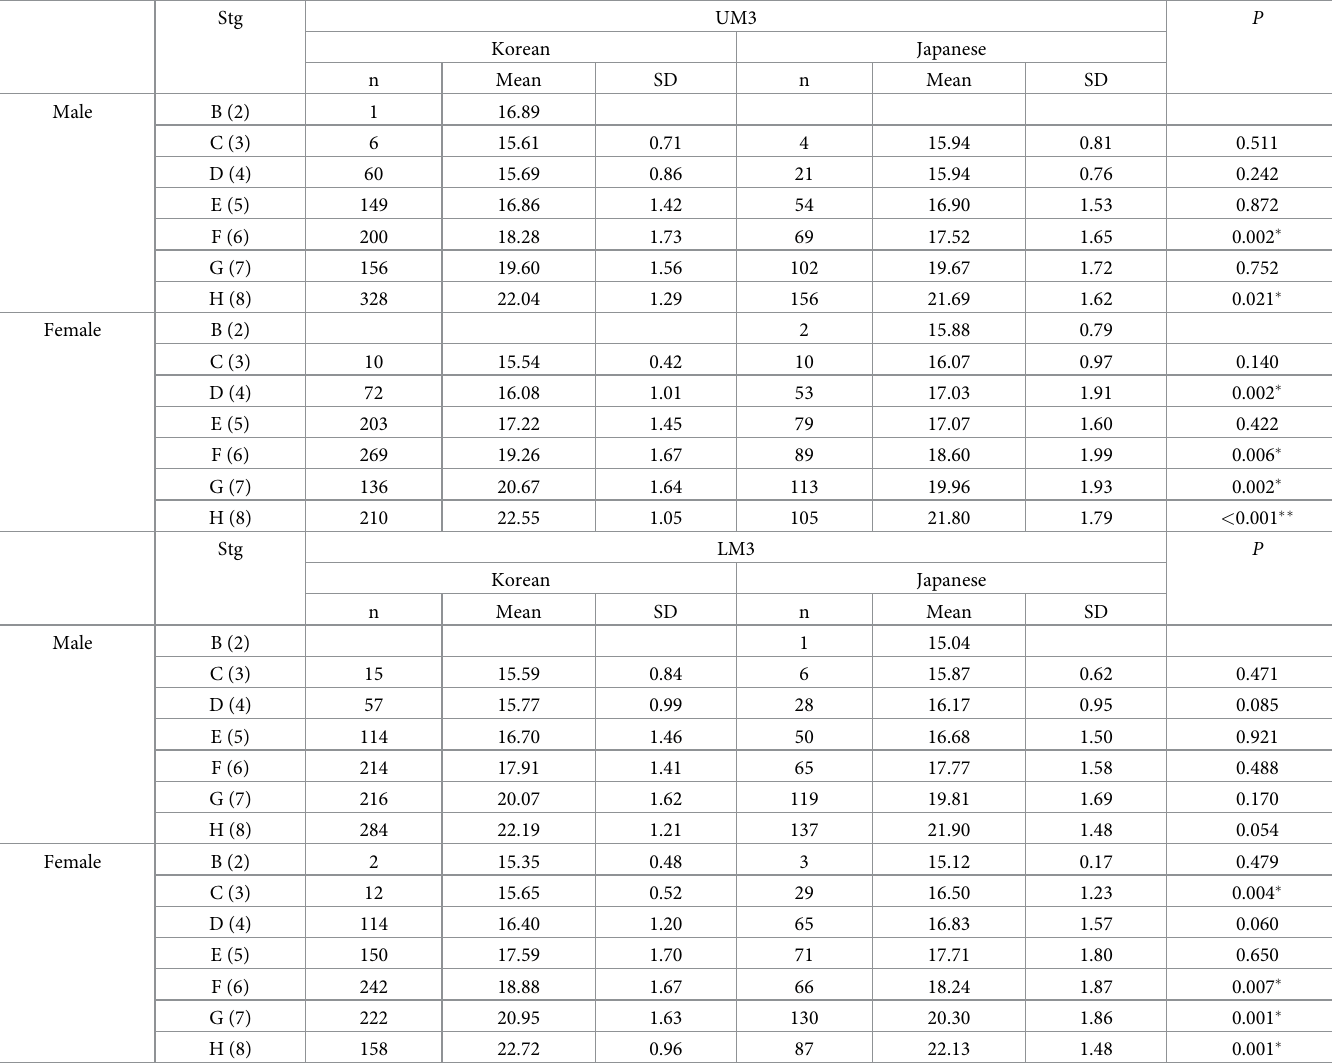
Table 3. Comparison of chronological age according to each stage of M3 between the Korean and Japanese